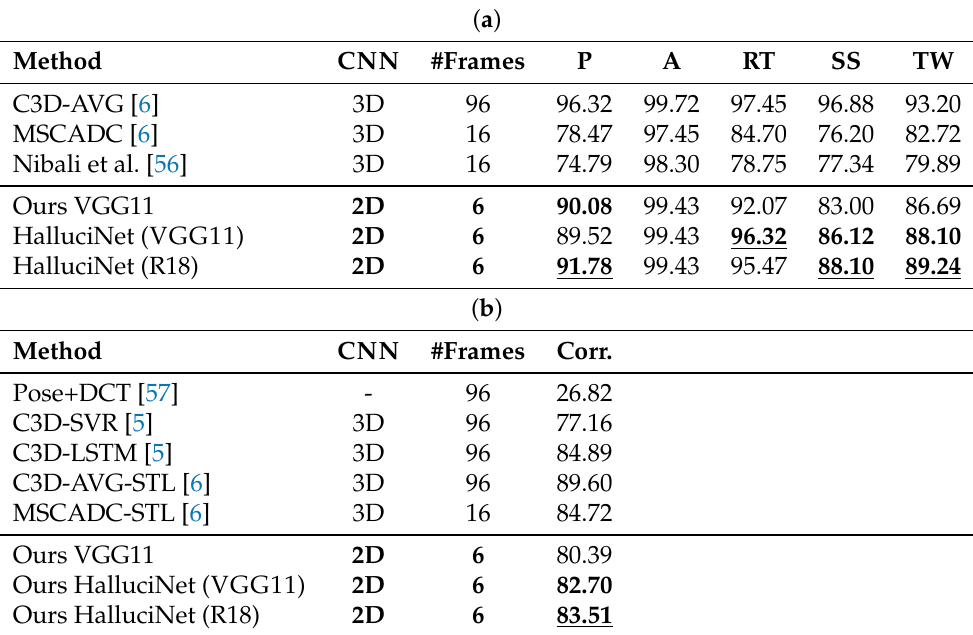
Table 3. ( a ) Performance (Accuracy in % reported) comparison on dive recognition task. #Frames represents the number of frames that the corresponding method sees. P, AS, RT, SS, TW stand for position, arm stand, rotation type, number of somersaults, and number of twists. ( b ) Performance (Spearman’s rank correlation in % reported) on AQA